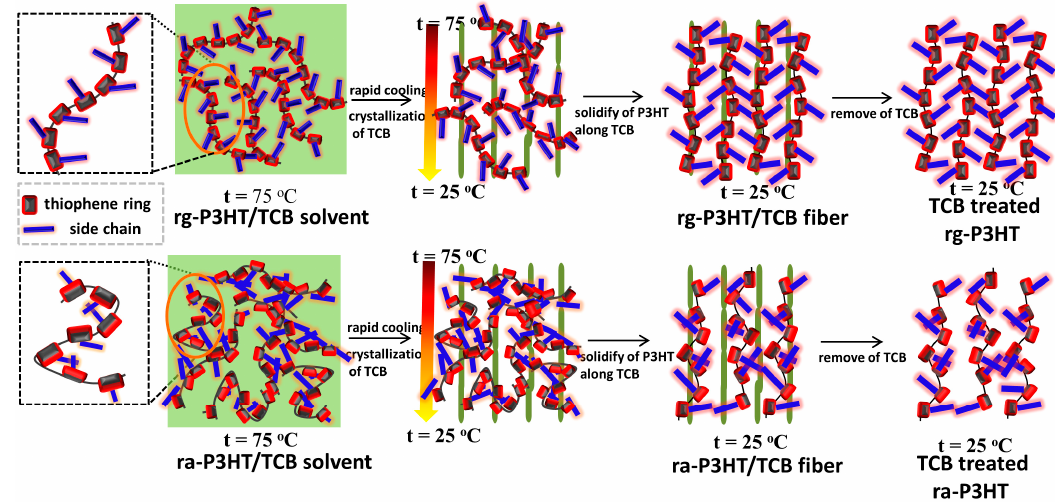
Figure 2. A schematic diagram of preparation of oriented rg-P3HT-TCB and ra-P3HT-TCB with fiber-like texture through a 1,3,5-trichlorobenzene (TCB) molecule epitaxy process. The mixture of rg-P3HT/TCB and ra-P3HT/TCB becomes a solvent after heating to 75 °C, and then the mixture cools down rapidly to 25 °C from one side to the other, forming a large temperature gradient. TCB solidified as a needle-like crystal along the temperature gradient. After doping and removing TCB, both of the rg-P3HT and ra-P3HT polymer chains formed a highly oriented structure.